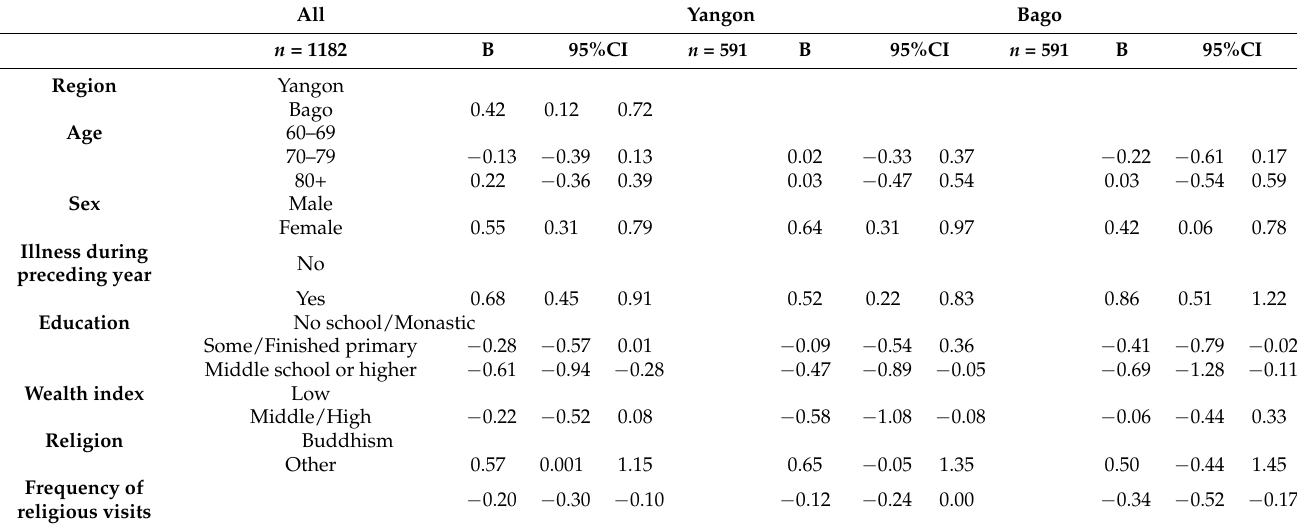
Table 2. Multivariate adjusted association between sociodemographic factors and Geriatric Depression Scale scores among older adults of the two regions in